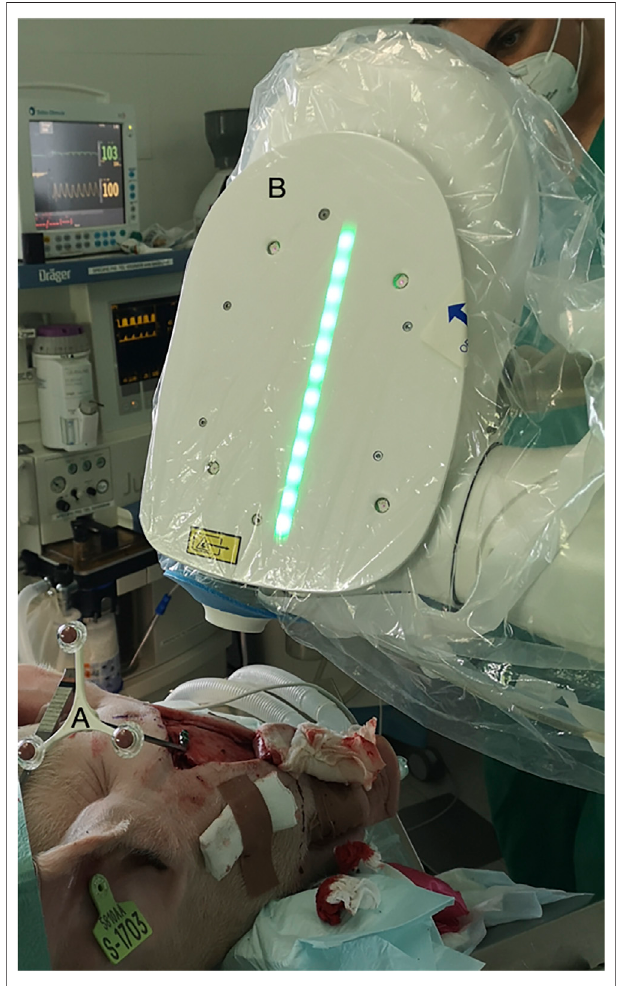
FIGURE 3 | Sterile robotic laser device in action. (A) Navigation Marker. (B) Sterile CARLO.